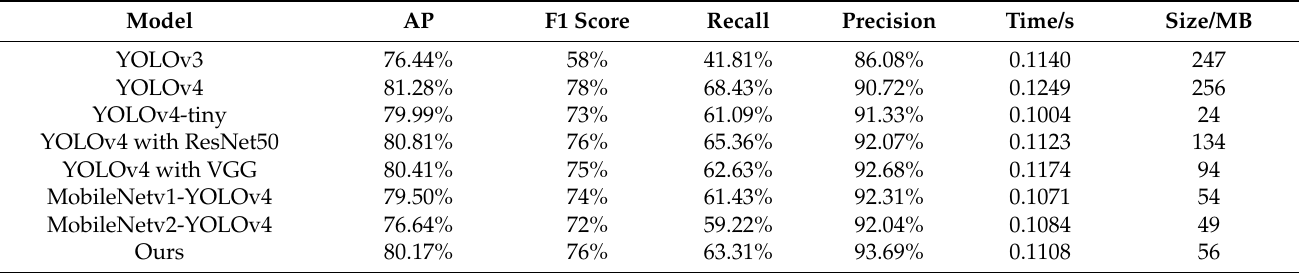
Figure 12. PR curves of YOLOv4 and improved models. Table 3. Performance comparison between different